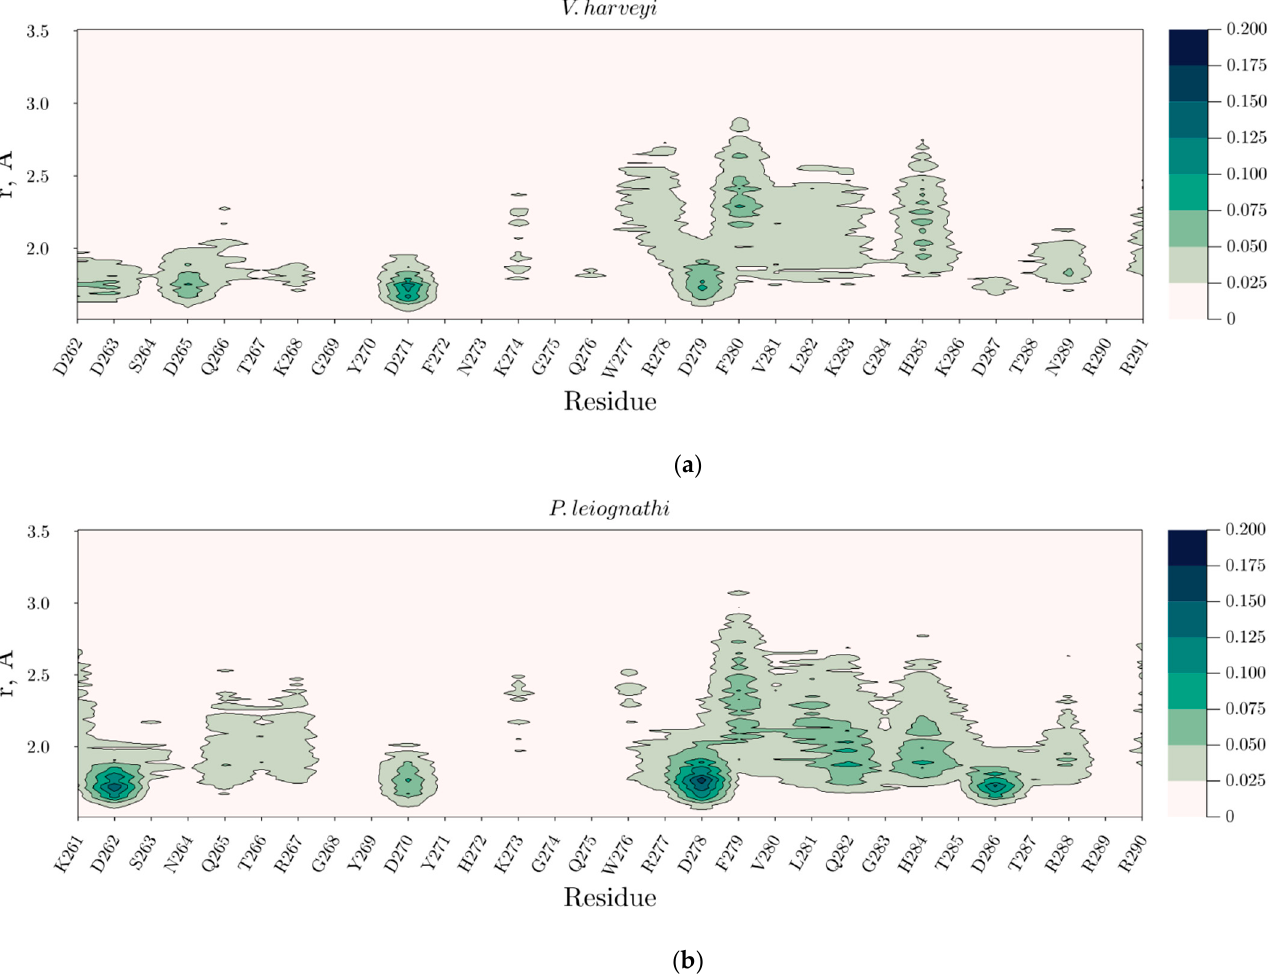
Figure 7. The density map of sucrose molecules near the mobile loop residues of V. harveyi ( a ) and P. leiognathi ( b ) luciferase at 60 °C during simulation time. The intensity of the green color indicates the probability of sucrose appearance in the distance r from the residue.